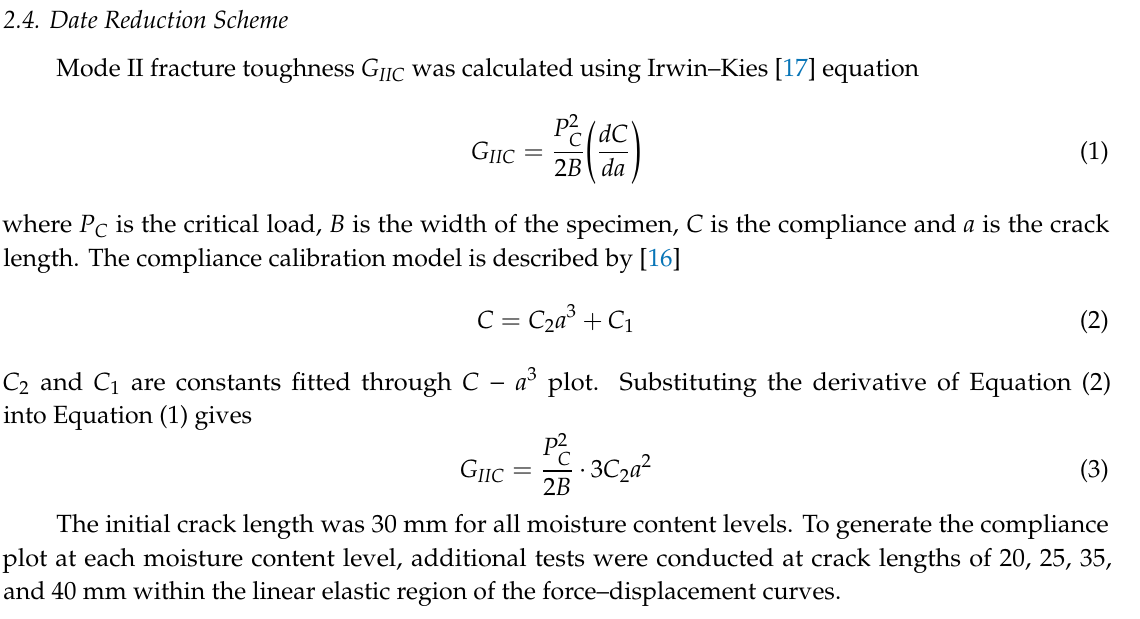
Figure 1. Schematic diagram of ENF test setup.